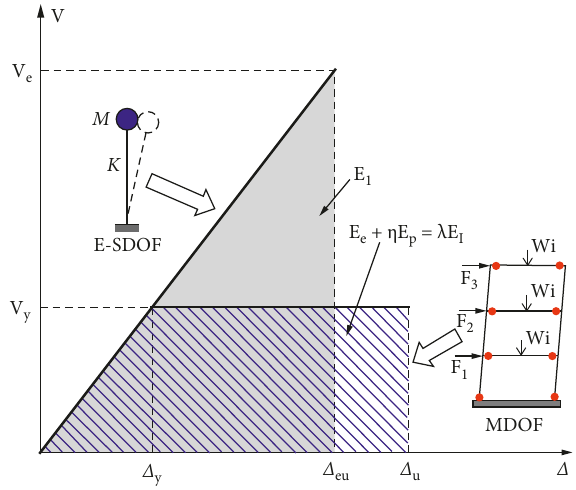
Figure 3: The concept of energy balance [26].